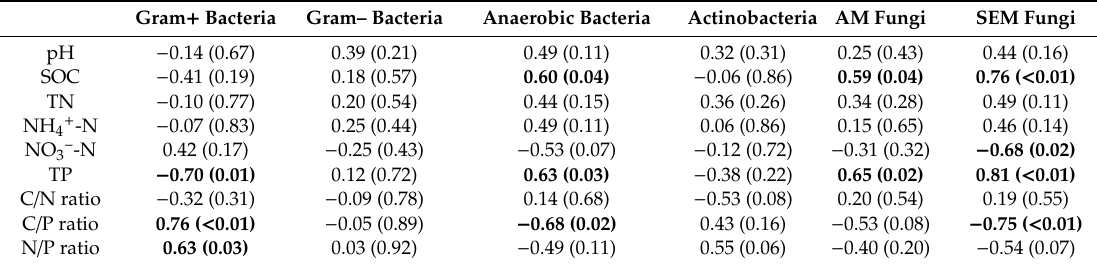
Table 2. Pearson’s correlation coe ffi cient ( R ) testing association between microbial group phospholipid fatty acids (PLFAs) and soil physicochemical properties. p -values are shown in the parenthesis. Bold values indicate significant e ff ects at p < 0.05 or p < 0.01.